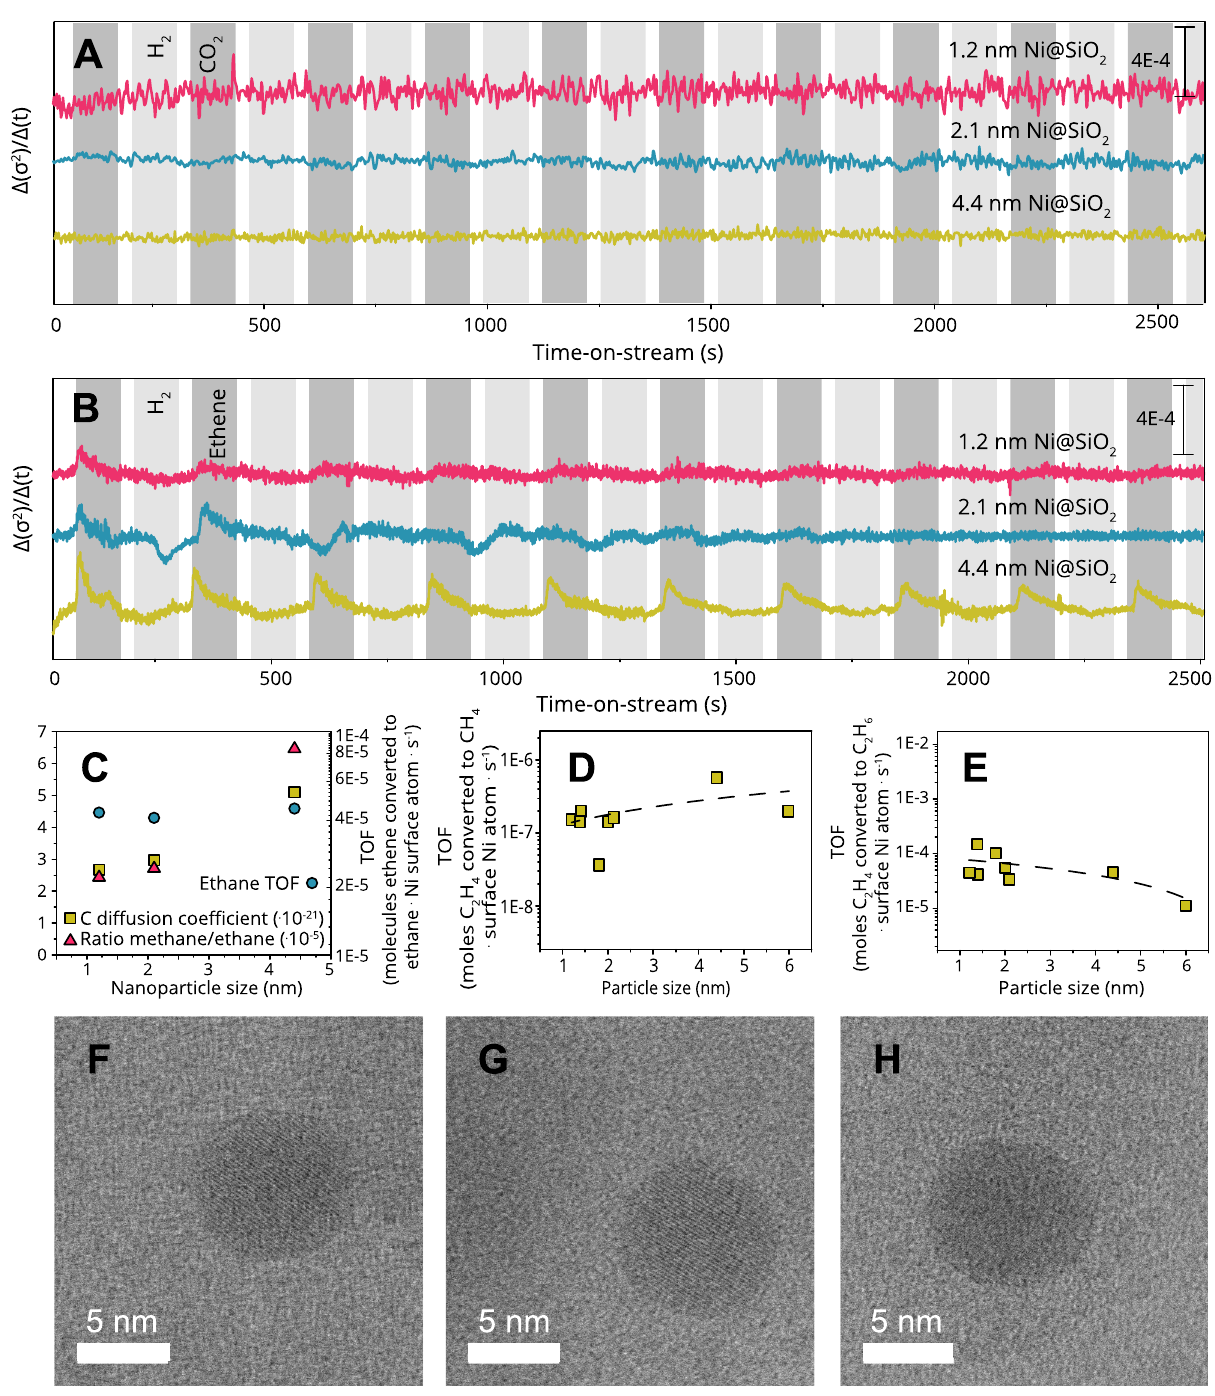
Fig. 3 Dynamics and extent of adsorbate-mediate restructuring under ethene fl ow, and its impact on products distribution. a , b Batch analysis of CO 2 - and ethene-pulsed modulated excitation experiments shown in Fig. 2. For each particle size, 50.000 – 70.000 spectra were individually fi t, fi xing the coordination number but varying σ 2 . The values have been given an arbitrary offset for clarity. c The diffusion coef fi cient of C as calculated from time- resolved XAS measurements, plotted with the ethane TOF and the ratio of methane/ethane for 3 catalyst samples with different mean Ni particle sizes. d , e The turnover frequency (TOF) of ethene converted to methane ( d ) and ethane ( e ) per surface nickel atom per second, measured at 150 °C 1:1 H 2 :ethene with a GHSV of 2.000. f , g , h In-situ BF-STEM images of nanoparticles deposited directly onto SiN membrane via spark ablation, in gaseous environment of f H 2 at 150 °C, g ethene at 150 °C, h and H 2 at 150